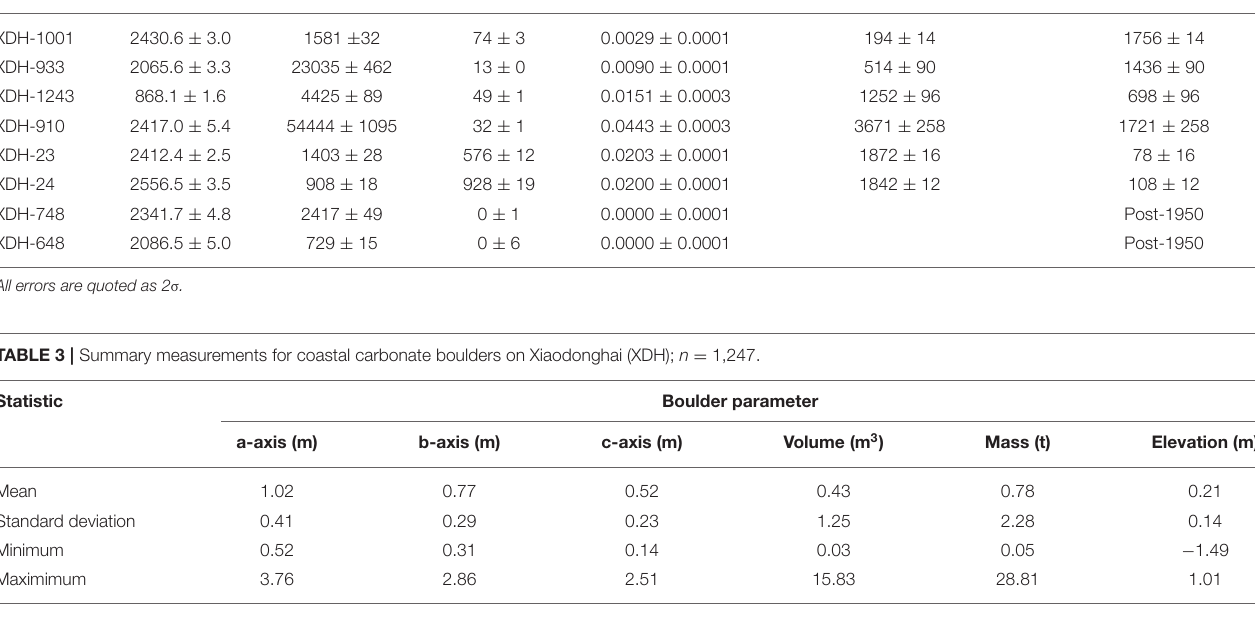
TABLE 2 | U/Th ages of six large coral boulders on XDH site. Boulder